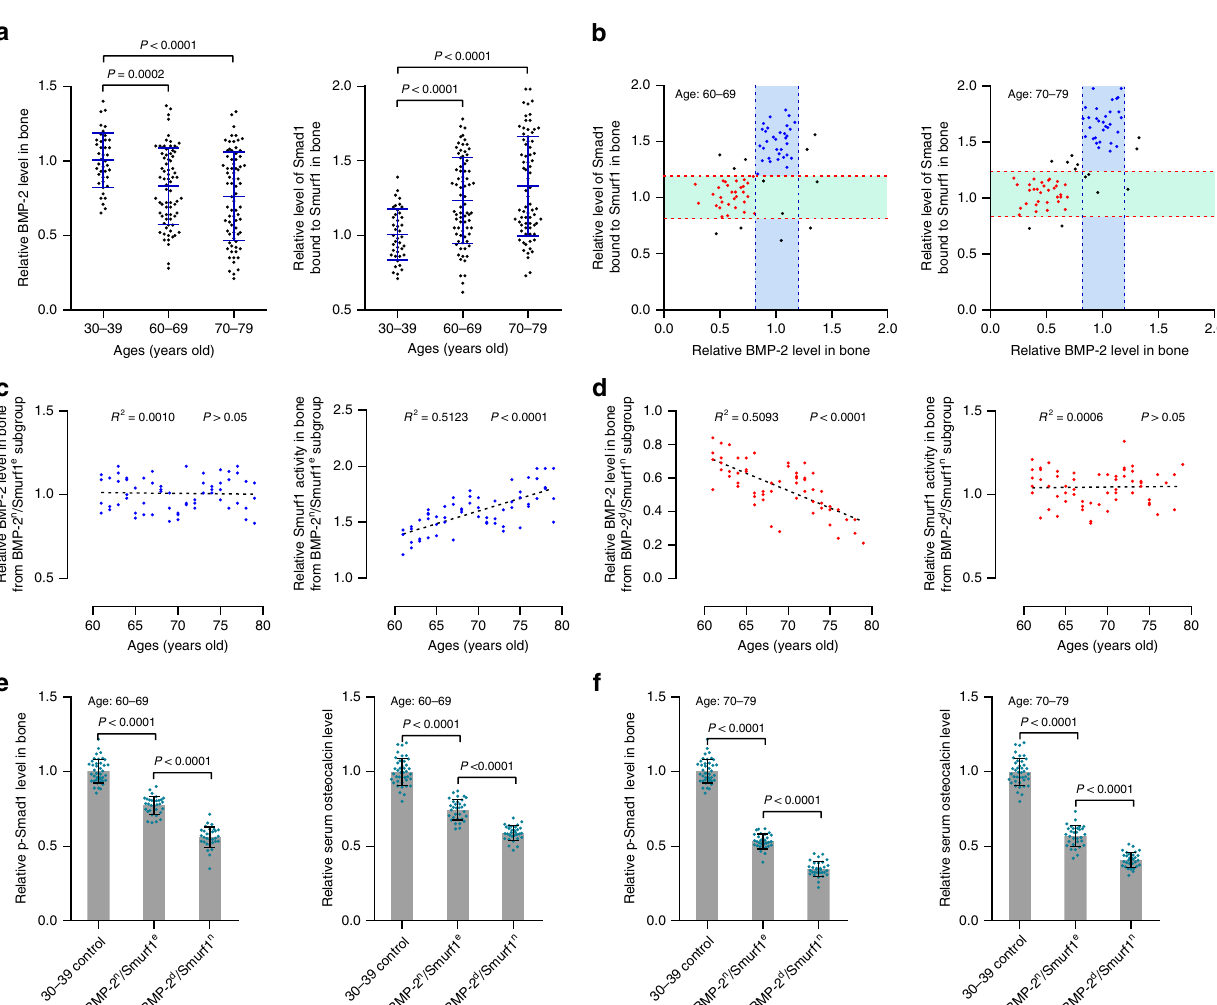
Subgroup classi fi cation of aged osteoporotic mice . Mice were ovariectomized (OVX) to induce age-related osteoporosis. In accordance with the fi ndings from human, osteoporotic mice showed unaltered Smurf1 expression, but decreased BMP-2 level and elevated Smurf1 activity (Smad1 bound to Smurf1) with large variations, when compared to healthy adult 6-month-old mice (Supplementary Fig. 3a). The osteoporotic mice were classi fi ed into BMP-2 n /Smurf1 e and BMP-2 d /Smurf1 n subgroups (Supple- mentary Fig. 3b). Elevation of Smurf1 activity (Smad1 bound to Smurf1, ubiquitination of Smad1 and Runx2) in BMP-2 n /Smurf1 e subgroup and reduction of BMP-2 level in BMP-2 d /Smurf1 n subgroup were in age-related manners (Supplementary Fig. 3c and 3d). Compared to BMP-2 n /Smurf1 e subgroup, age-related NATURE COMMUNICATIONS| (2018) 9:3428 |DOI: 10.1038/s41467-018-05974-z|www.nature.com/naturecommunications